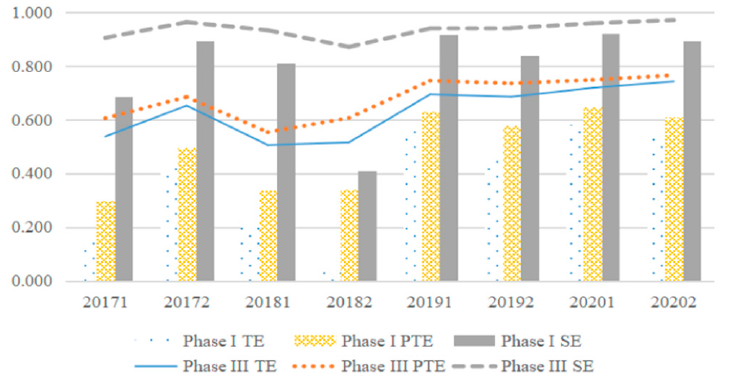
Figure 1. Comparison of Phase 1 and Phase 3 results for listed companies in the construction industry, 2017–2020.